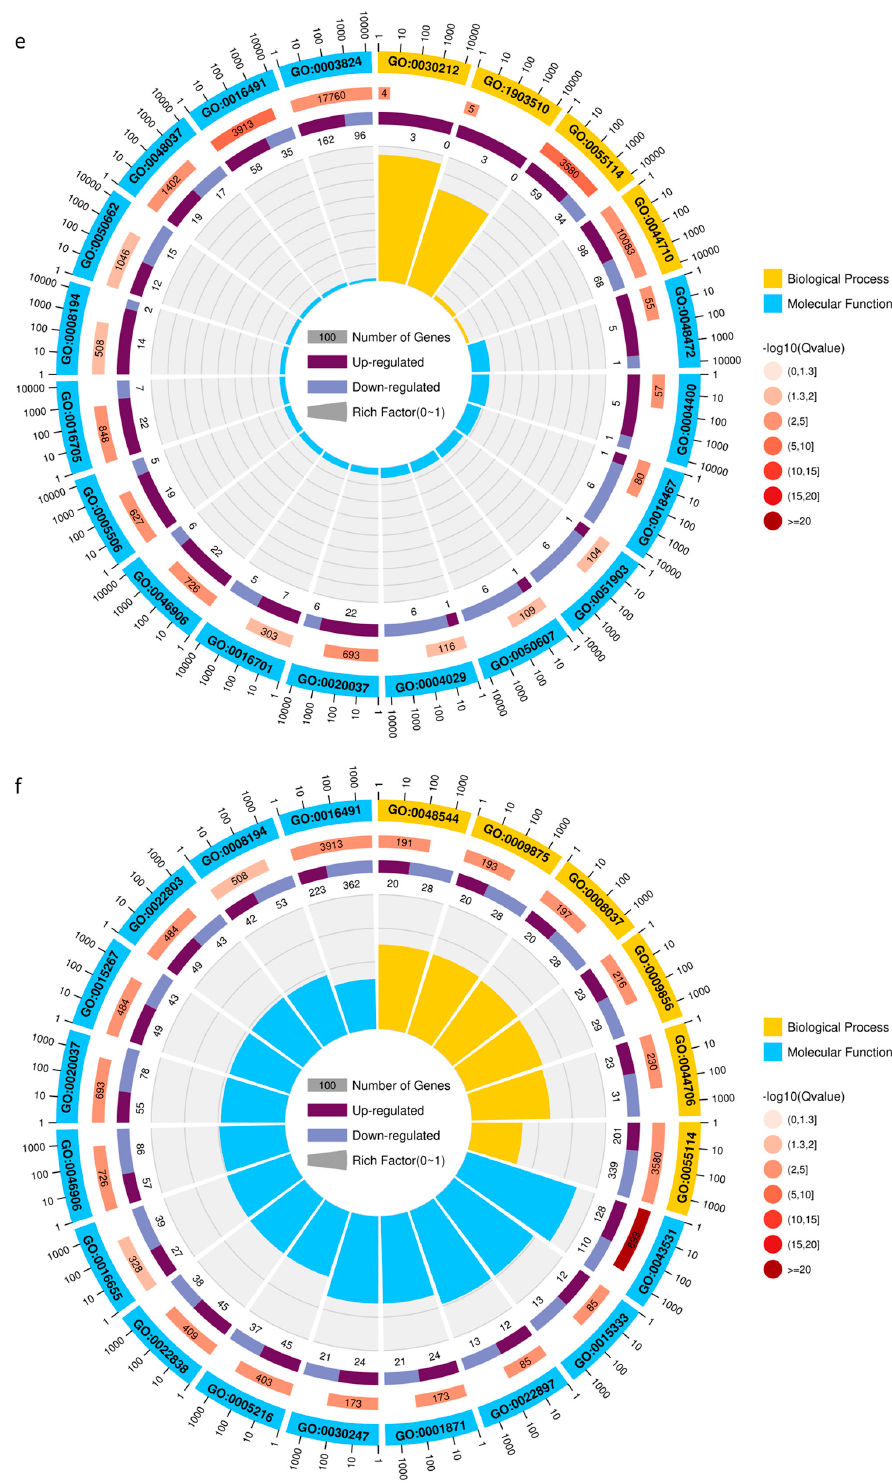
Figure 2. The top 20 GO terms for DEGs in three combinations. ( a ) The top 20 GO terms for DEGs in M-CKL vs. M-TL. ( b ) The top 20 GO terms for DEGs in Z-CKL vs. Z-TL. ( c ) The top 20 GO terms for DEGs in M-TL vs. Z-TL. ( d ) The top 20 GO terms for DEGs in M-CKR vs. M-TR. ( e ) The top 20 GO terms for DEGs in Z-CKR vs. Z-TR. ( f ) The top 20 GO terms for DEGs in M-TR vs. Z-TR.